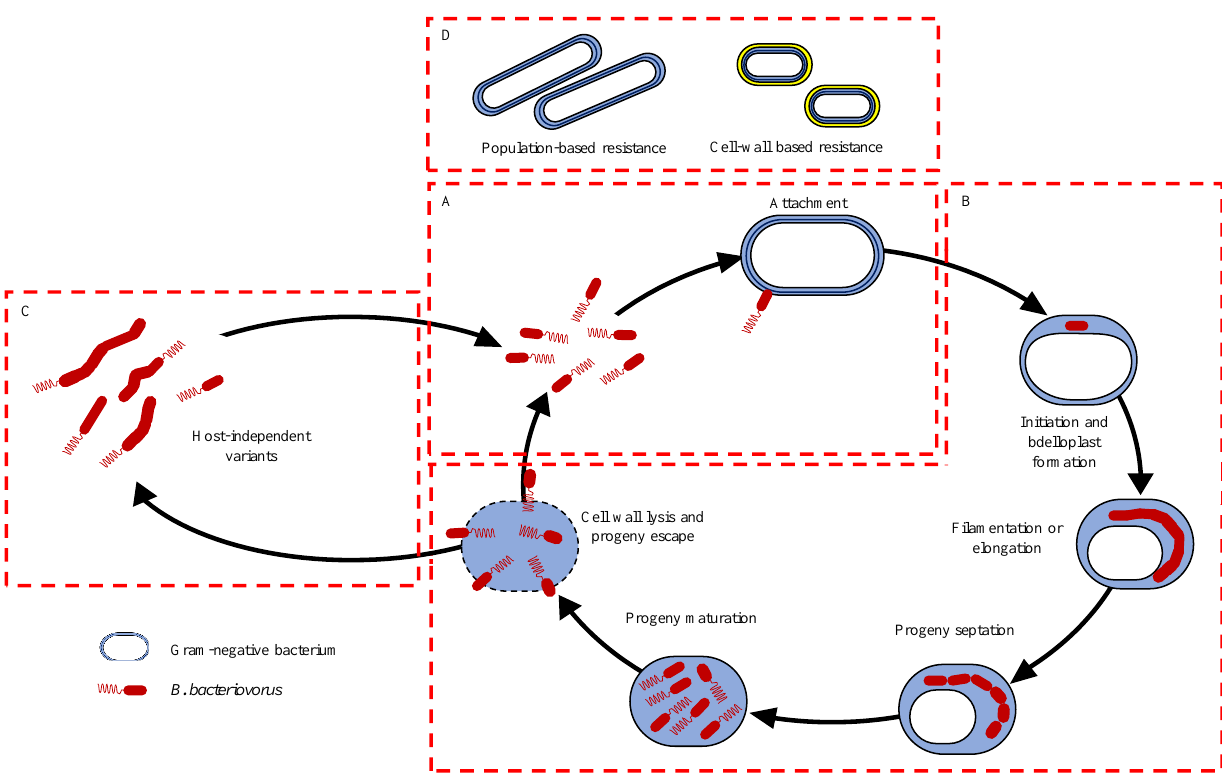
Figure 3. Schematics representation of the proposed life cycle of B. bacteriovorus (predator) preying on Gram-negative bacterium (prey): ( A ) Attack phase; ( B ) Periplasmic growth phase; ( C ) Host-independent (HI) phase; ( D ) Proposed predation resistance mechanisms including population-based resistance (plastic phenotypic resistance) and cell wall-based resistance mechanisms (production of procrystalline protein or S-layer) (adapted from Shemesh and Jurkevitch [84]; Marine et al. [82]).The in vivo antimicrobial activity of B. bacteriovorus has also been demonstrated, with Shatzkes et al. [87] applying the B. bacteriovorus 109J strain to murine (SD rats) models infected with a lethal dose (3.3 × 10 7 CFU/rat) of K. pneumoniae ATCC 43816. The predator strain significantly reduced (99.9%) K. pneumoniae ATCC 43816 cell counts in vivo, with no adverse effects observed following treatment. In addition, Findlay et al. [88] demonstrated the efficiency of B. bacteriovorus HD100 pre-treatment in a murine model (SKH- 1 mice) against a lethal infection (~1000 CFU/100 μL) of Yersinia pestis ( Y. pestis ) CO92. The Y. pestis CO92 cell counts were significantly reduced (<10 CFU) following admin- istration to the B. bacteriovorus HD100 pre-treated murine (SKH-1 mice) models. Additionally, to date, deleterious effects, following the application of B. bacteriovorus by ingestion and/or injection, have not been reported, which further validates the application of the predatory bacteria as a po- tential biological control strategy for the treatment of MDR, XDR, or PDR A. baumannii strains [89]. Bdellovibrio bacteriovorus Therapy: Current Limitations and Potential Mitigation Strate- gies While B. bacteriovorus resistance has not been detected amongst A. baumannii strains, previous studies have observed that certain bacterial species exhibit (1) population-based resistance (plastic phenotypic resistance) and (2) cell-wall based resistance (production of procrystalline protein or S-layer), when exposed to various predatory strains (Figure 3) (Shemesh and Jurkevitch 2004). Thus, as Bdellovibrio spp. have been observed to exhibit inherent resistance to β -lactam antibiotics and antifolates, it has been hypothesised that Bdellovibrio spp. could serve as potentiators or adjuvants to conventional antibiotics (pen- icillins, carbapenems, and trimethoprim) or antimicrobials, which, in turn, may mitigate the development of predator and/or antibiotic resistance [82,83]. Im et al. [90] demon- strated the antimicrobial efficacy of B. bacteriovorus HD100 in combination with violacein (bis-indole pigment derived from Pseudoduganella violaceinigra sp. NI28) against Gram-